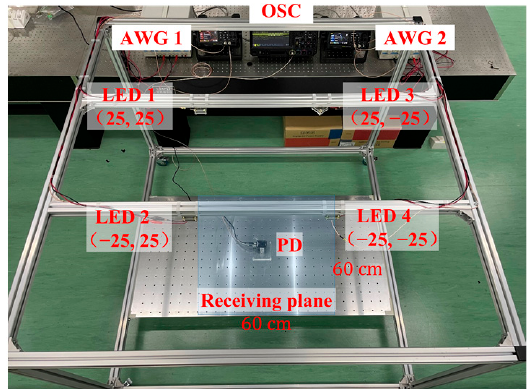
Figure 3. Diagram of the experimental platform for the multi-user VLCP system.